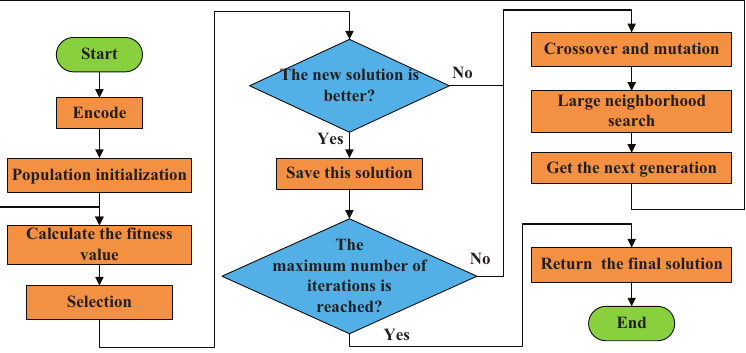
Figure 1. The flowchart of the GA-LNS